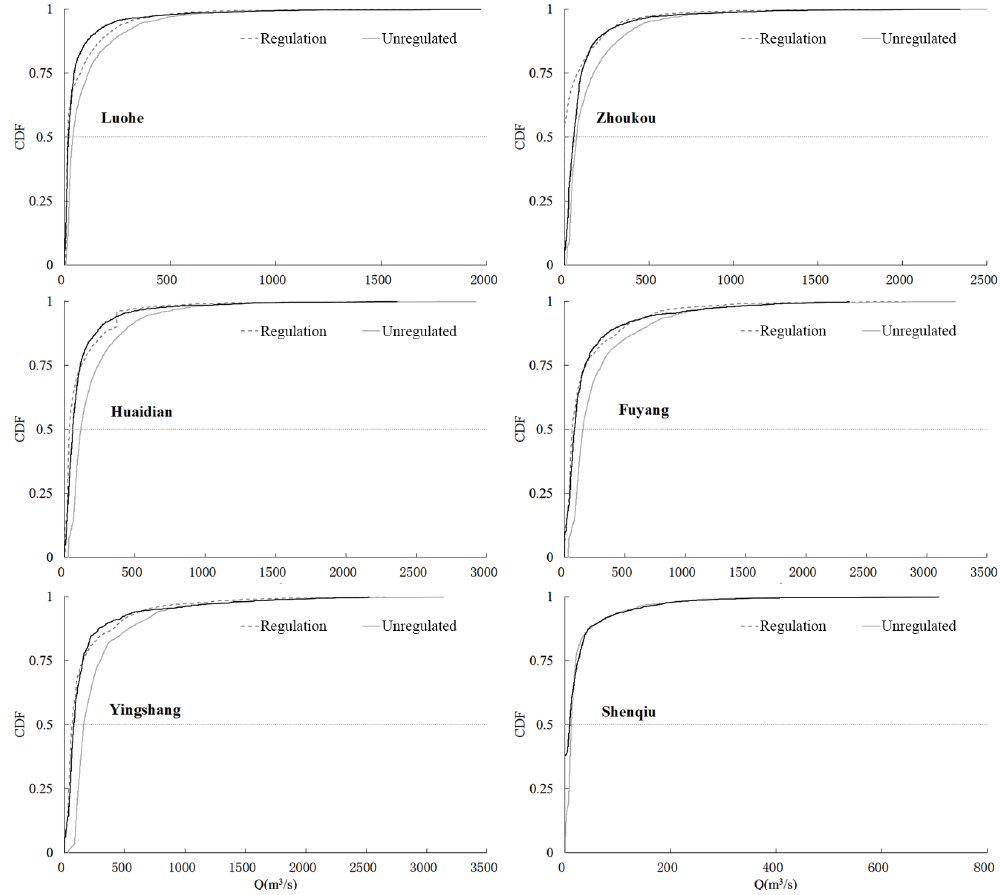
Figure 8. The cumulative distributions of simulated and observed daily runoff at all stations. Table 4. The runoff simulation results at regulated stations with and without the dam regulation considered. Range means the difference of the objective function value between regulations considered and not considered. If the range value is less than 0.0, then the simulation with regulation is better than that without regulation. Otherwise, the simulation without regulation is